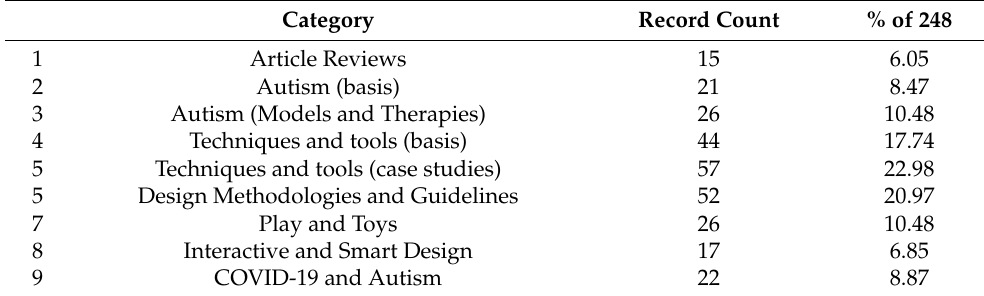
Table 7. Resources focused on autism for each category.